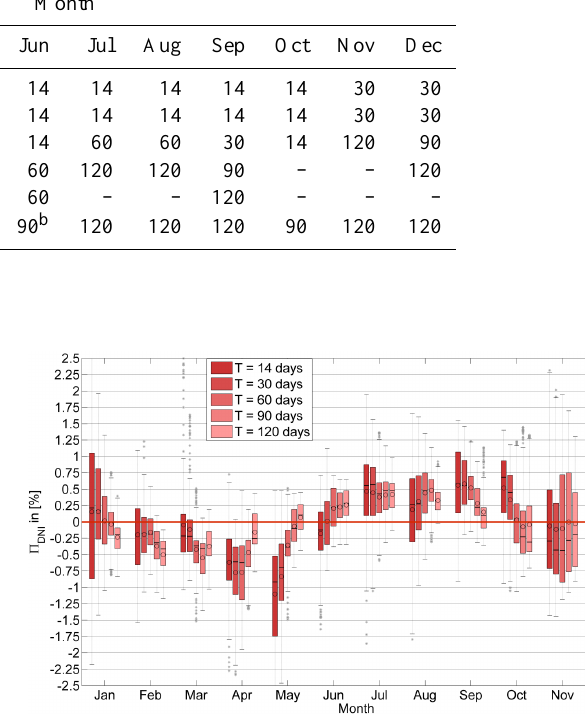
Table 7. VigKing: Minimum required calibration duration in days for given maximum of (cid:53) DNI and starting time. (cid:53) DNI , max